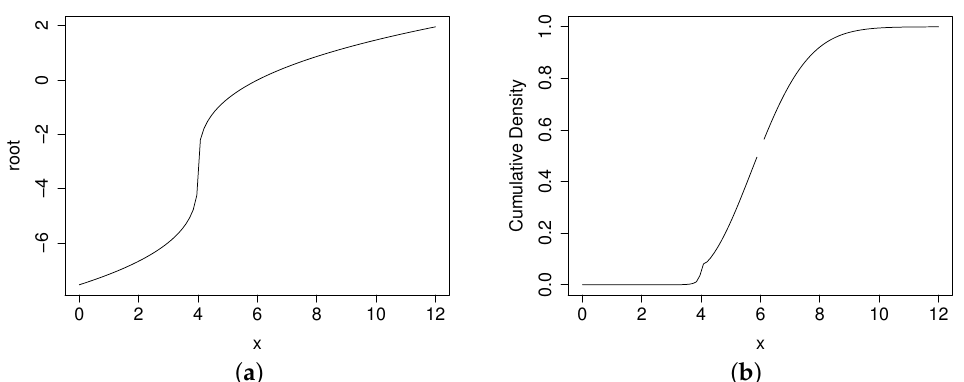
Figure 3. ( a ) Plot of the root θ 0 of a TS( κ ∗ X ∼ Gamma ( 2,3 ) process variable. ( b ) Plot of the corresponding TS( κ ∗